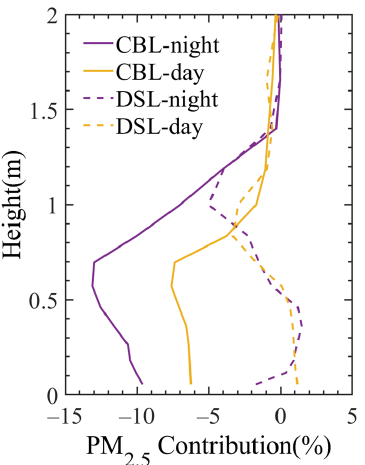
Figure 6. Vertical distribution of PM 2.5 contribution differences (%) between the lake experiment and no-lake experiment averaged for CBLs and DSLs below 2 km in the atmosphere during the air pollution process of 19–22 January 2018. The yellow and purple lines represent the daytime at 14:00 (local time) and the nighttime at 02:00 (local time).